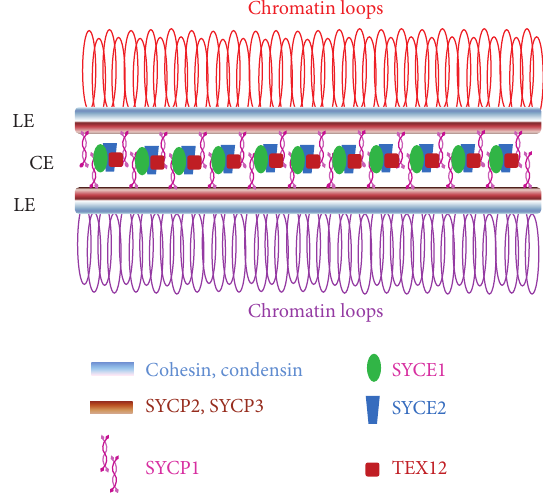
F 2: Cartoon showing the structure and major components of the lateral elements (LEs) and central element (CE) of the synaptonemal complex in mammals. Chromatin loops of each chromosome of the homologous pair emanate from each